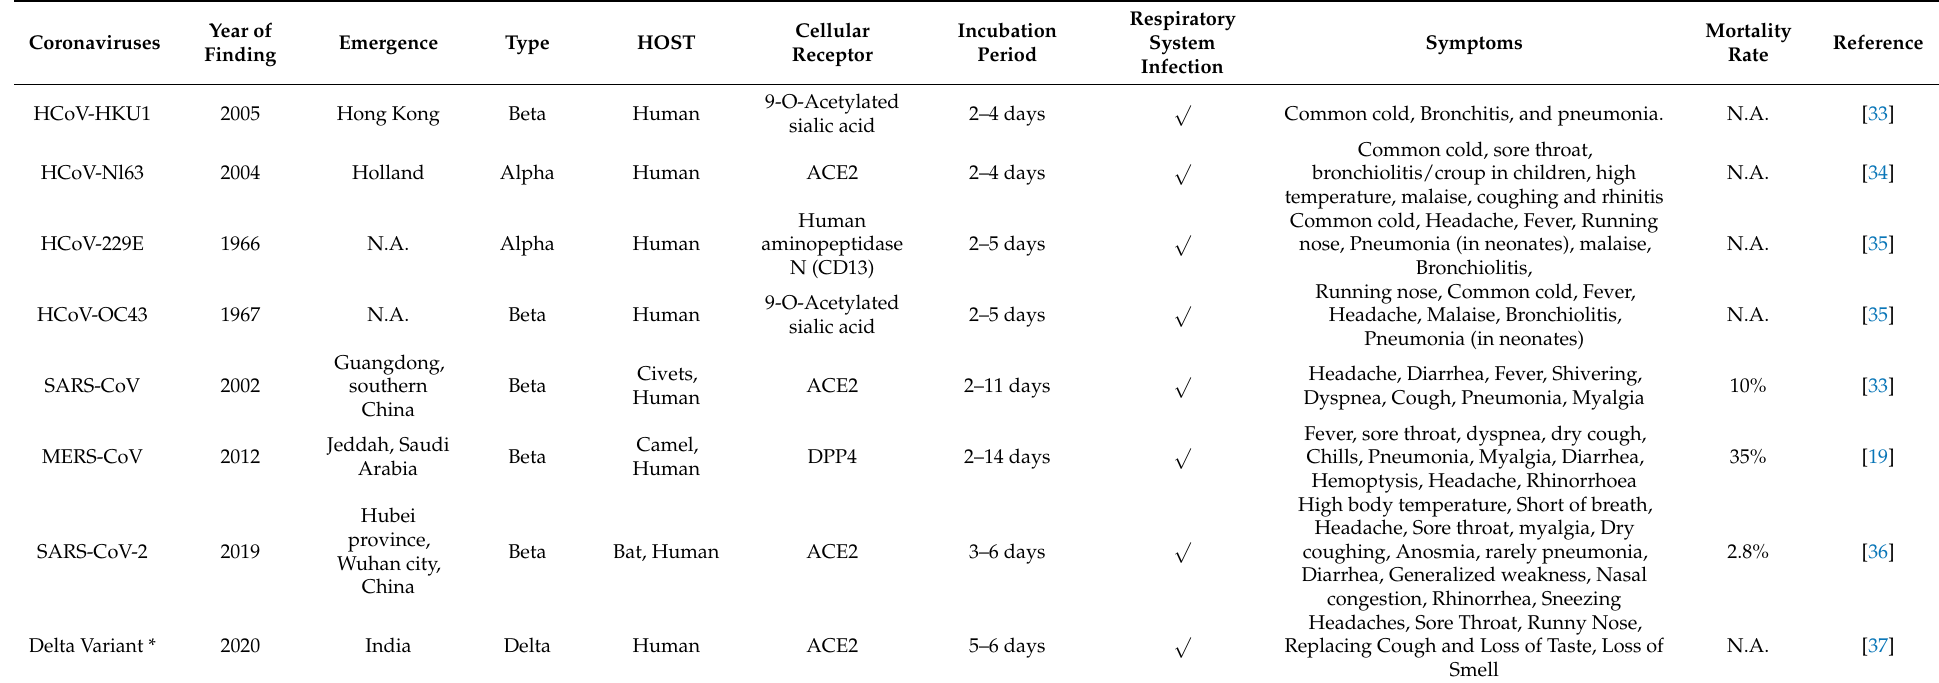
Table 1. Comparative Coronaviruses that infect the human body respiratory